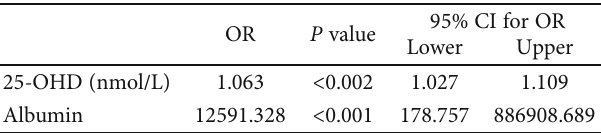
The table is showing multiple logistic regression for the serum 25-OHD levels and serum albumin levels with positive OR, con fi rming our theory that low serum level of 25-OHD is associated with increased severity of the liver disease and